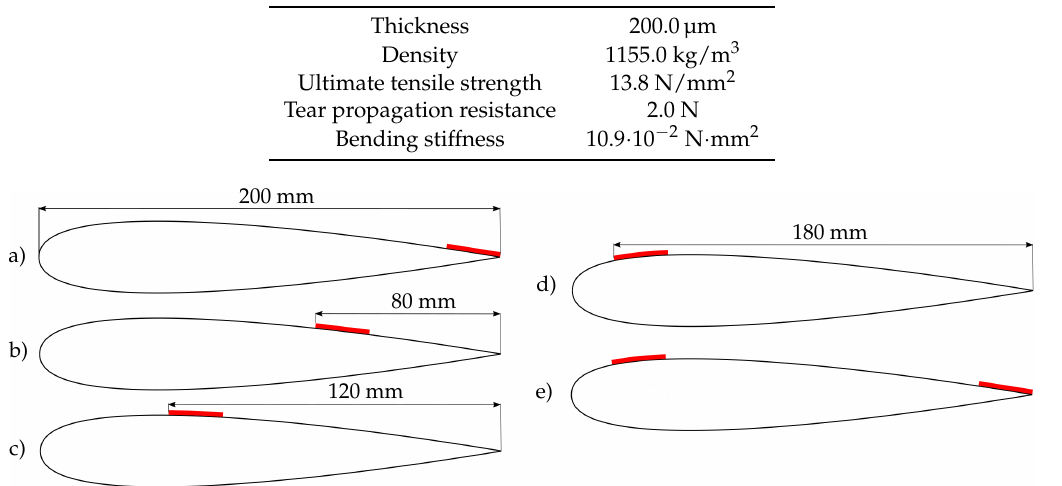
Figure 4. Silicone flap row positions on the NACA0020 profile; ( a ) corresponds to the trailing edge (TE), ( b ) corresponds to flaps that are placed 80mm from the trailing edge, ( c ) corresponds to flaps that are placed 120mm from the trailing edge, ( d ) corresponds to flaps at the leading edge (LE) and ( e ) corresponds to flaps at leading and trailing edge.